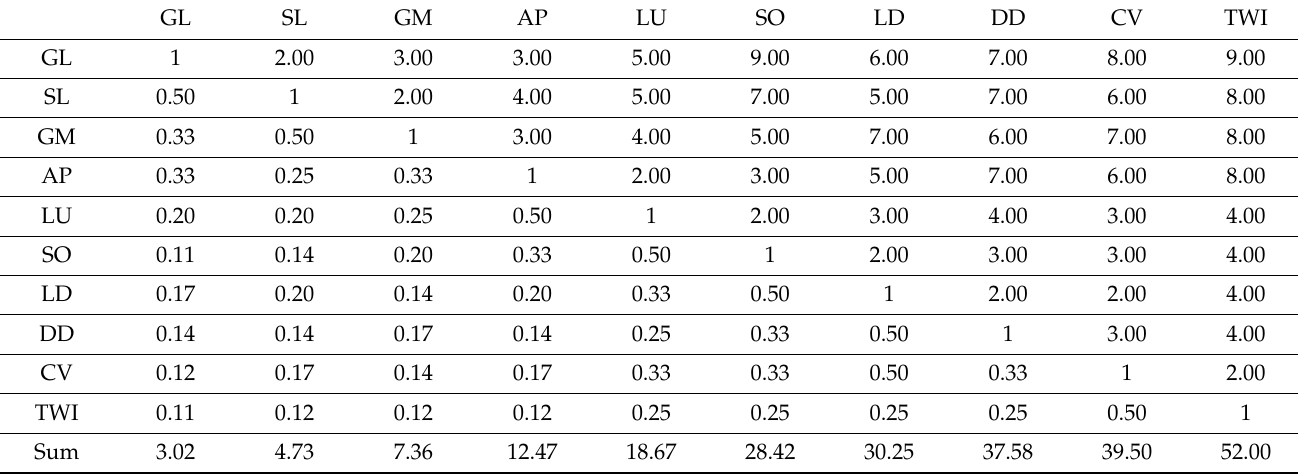
Table 3. Pairwise comparison matrix of the thematic layers.